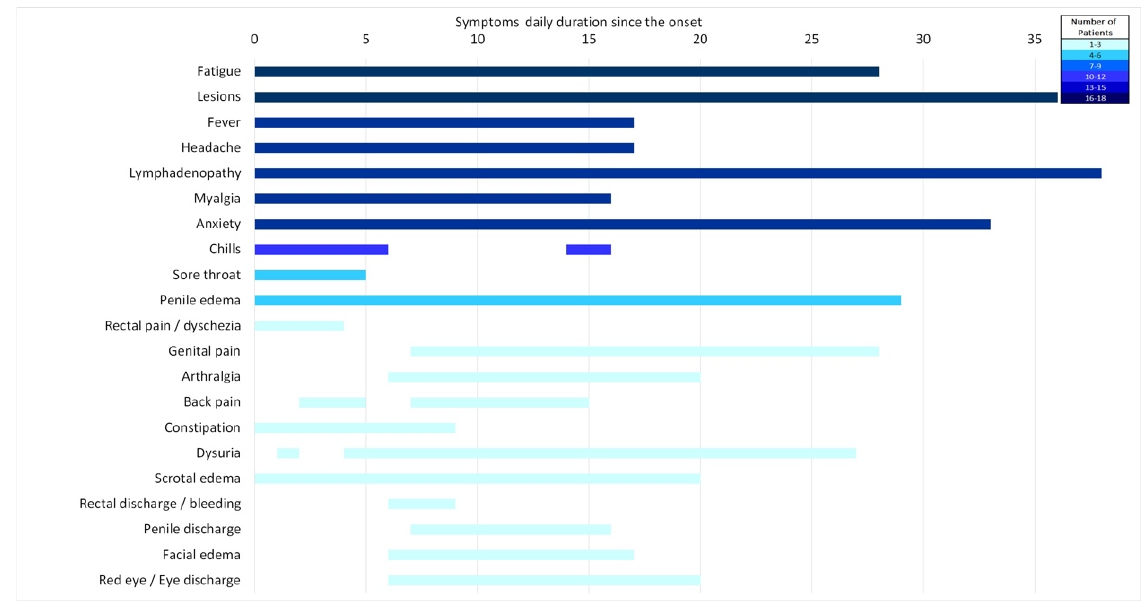
Figure 6. Duration of symptoms, relative to the number of patients who reported them on that day (color coded, legend).